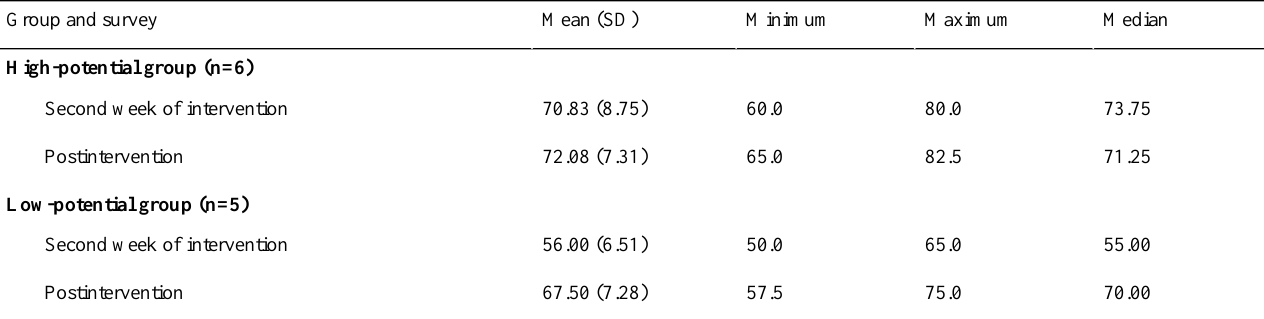
Table 2. Scores of the System Usability Scale (SUS) from the second-week and postintervention surveys for the high-potential and low-potential groups